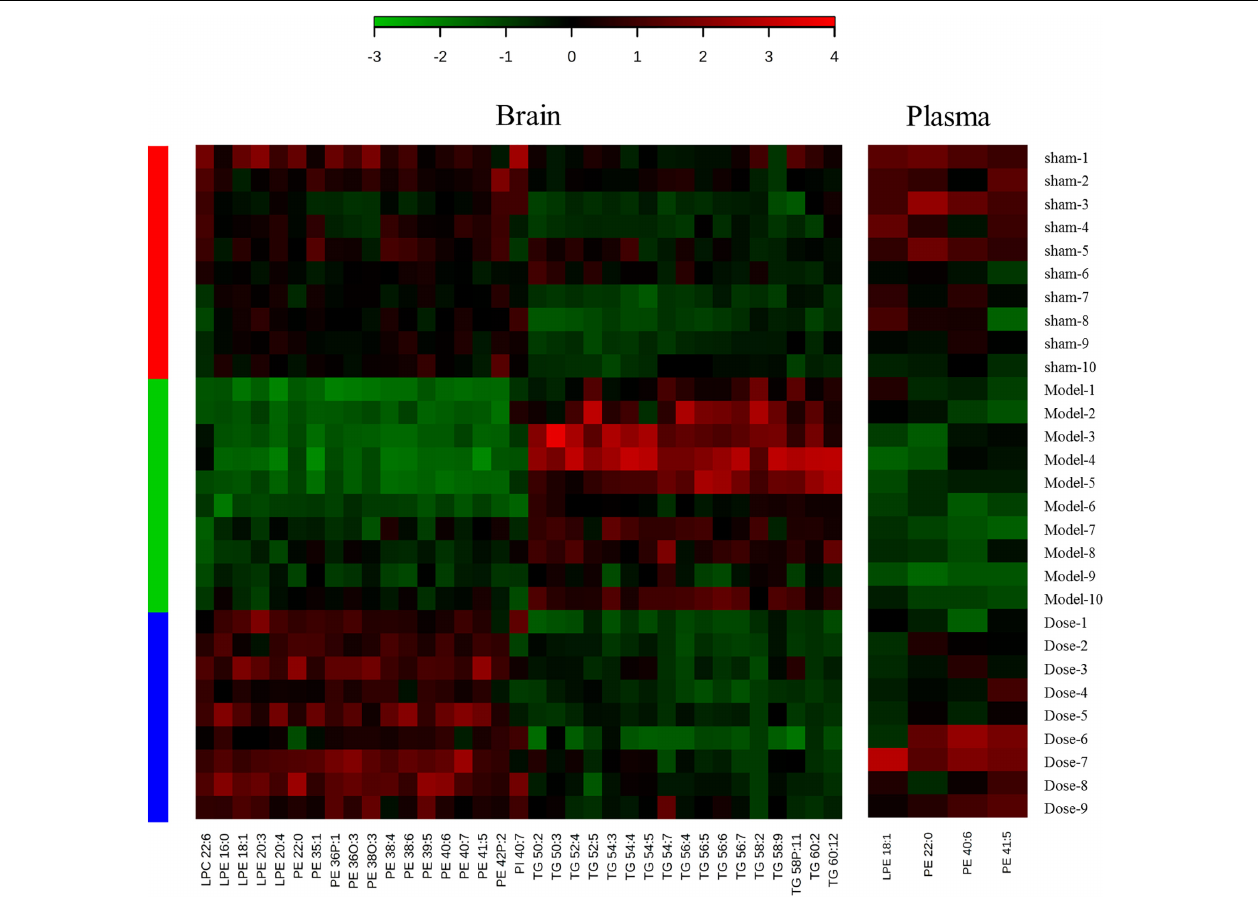
FIGURE 3 | Heat maps of potential biomarkers with return tendency. The abscissa is the compound name, and the ordinate is the number of animals. Groups are listed on the left: red is the sham operation group, green is the model group, and blue is the dosed model group. Green patches represent a decrease, and red patches represent an increase. The color reference is provided by the scale bar at the